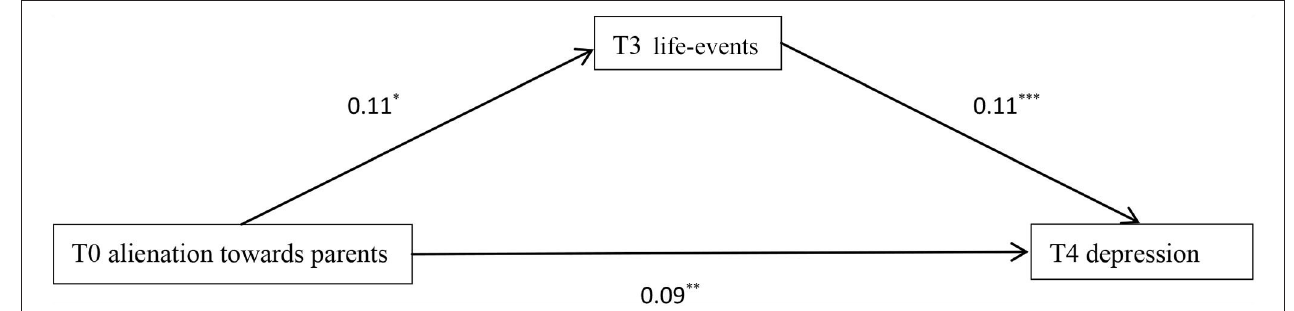
FIGURE 1 | Mediation of T3 life-events in the prediction of T0 alienation toward parents on T4 depression. * p < 0.05, ** p < 0.01, *** p <